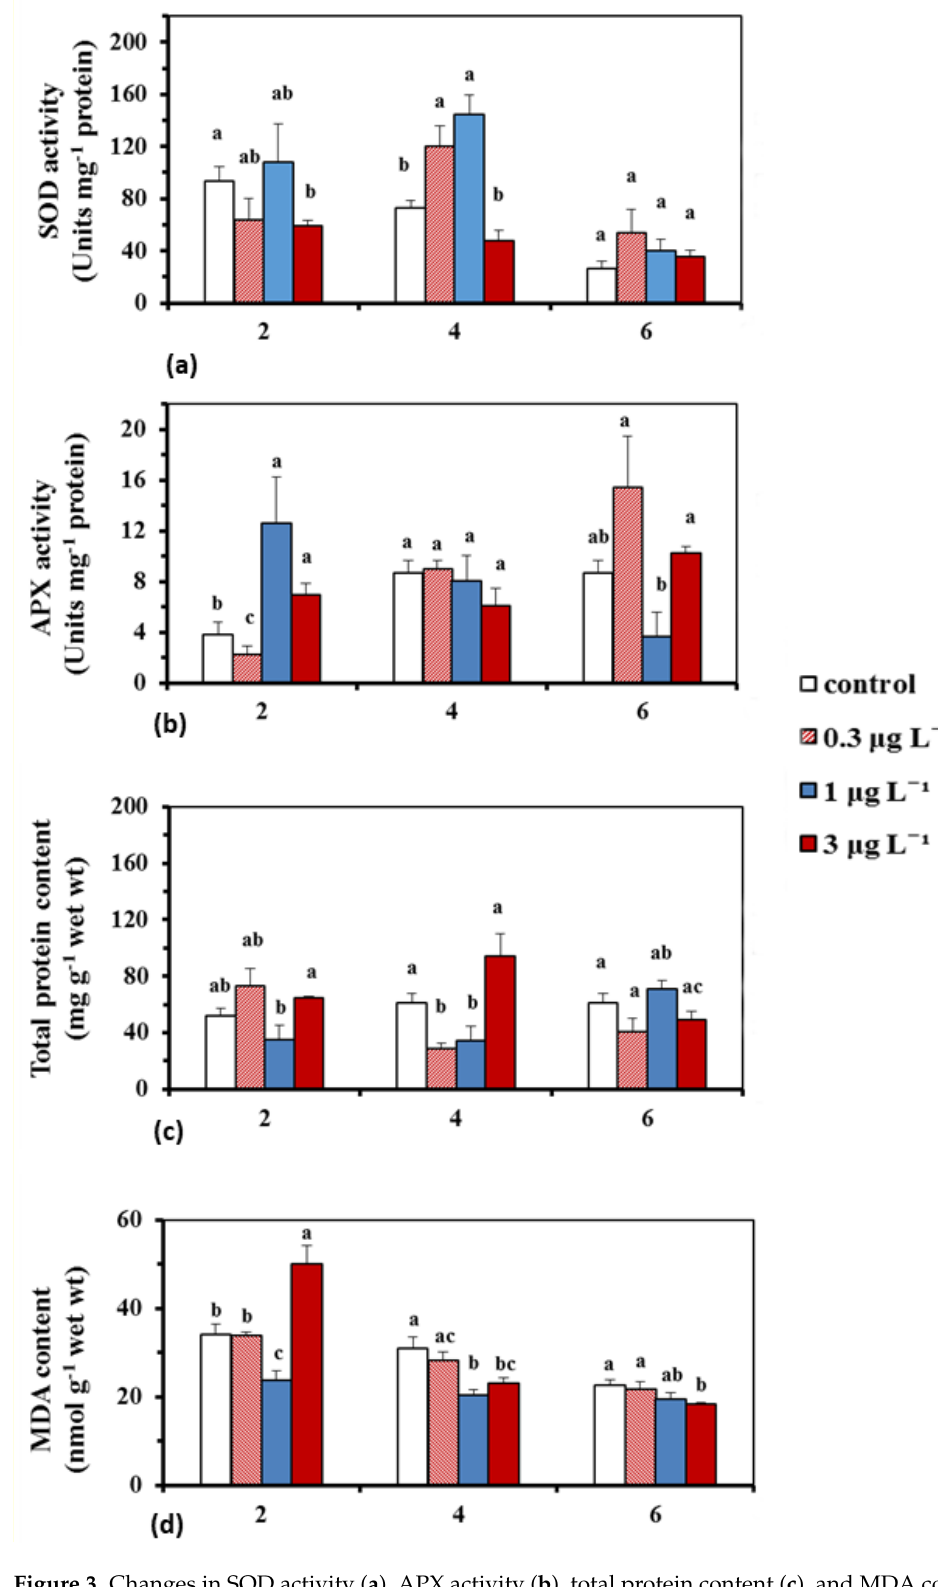
Figure 3. Changes in SOD activity ( a ), APX activity ( b ), total protein content ( c ), and MDA content ( d ) in Cymodocea nodosa intermediate leaves, at 0.3, 1 and 3 μ g L − 1 BPA treatments and in the control, exposed for 2, 4 and 6 days; mean ± SE from three subsamples; different letters express significantly different values between treatments and the control and between treatments (Mann–Whitney U–test; p < 0.05).